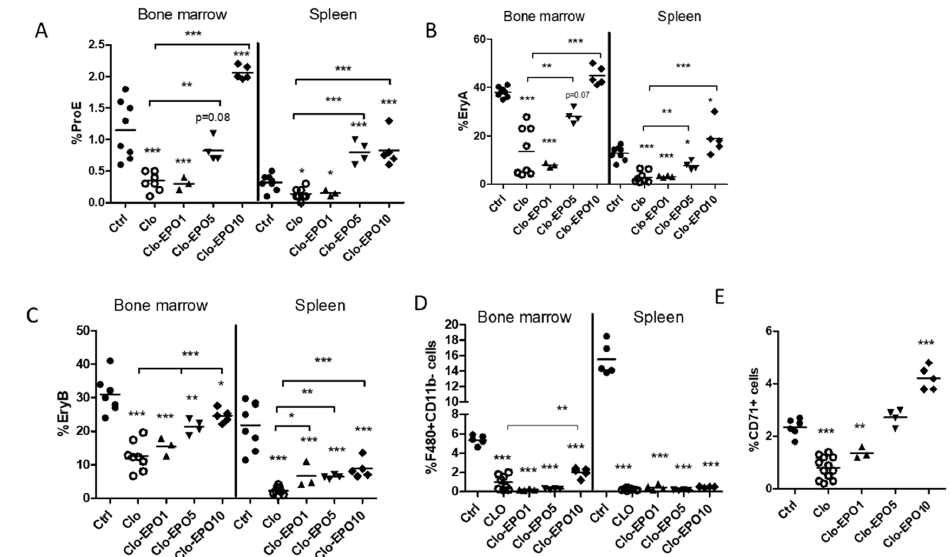
Figure 5. Effect of exogenous EPO on bone marrow and splenic erythroblasts populations from mice treated with clodronate liposomes. Proportions of ( A ) ProE, ( B ) EryA, and ( C ) EryB in the bone marrow and the spleen from control (Ctrl), clodronate-treated (Clo) mice, and clodronate-treated mice receiving rHuEPO at 1 IU (Clo-EPO1), 5 IU (Clo-EOI5) or 10 IU (Clo-EPO10) doses. ( D ) Percentages of F4-80 + CD11b − cells in the BM and spleen. ( E ) Reticulocytes (CD71 + cells) in blood at day 4 post-treatment. BALB / c mice were injected with a single dose of clodronate liposomes and treated with rHuEPO 24 and 48 h after. Mice were sacrificed at day 4. *** p < 0.001, ** p < 0.01, * p <